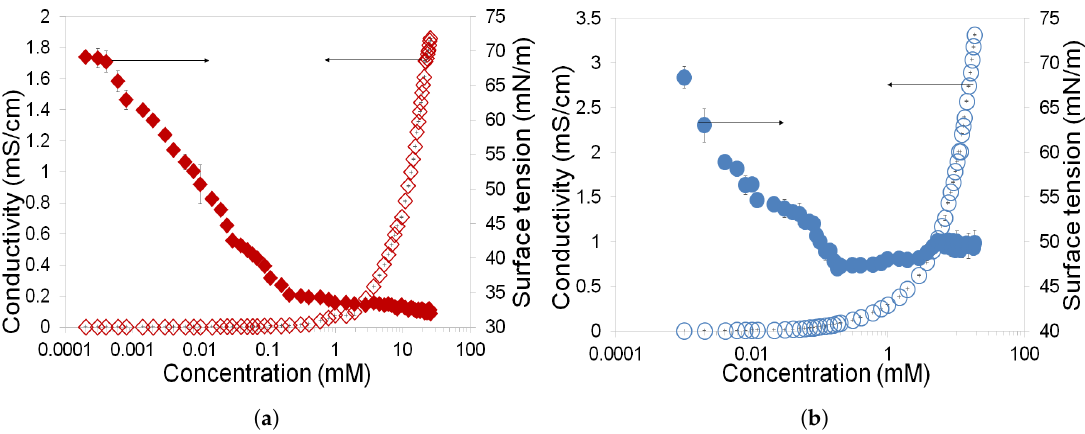
Figure 1. Plots of surface tension (filled symbols) and conductivity (unfilled symbols) against concentration of aqueous solution of ( a ) rhamnolipid ( b )